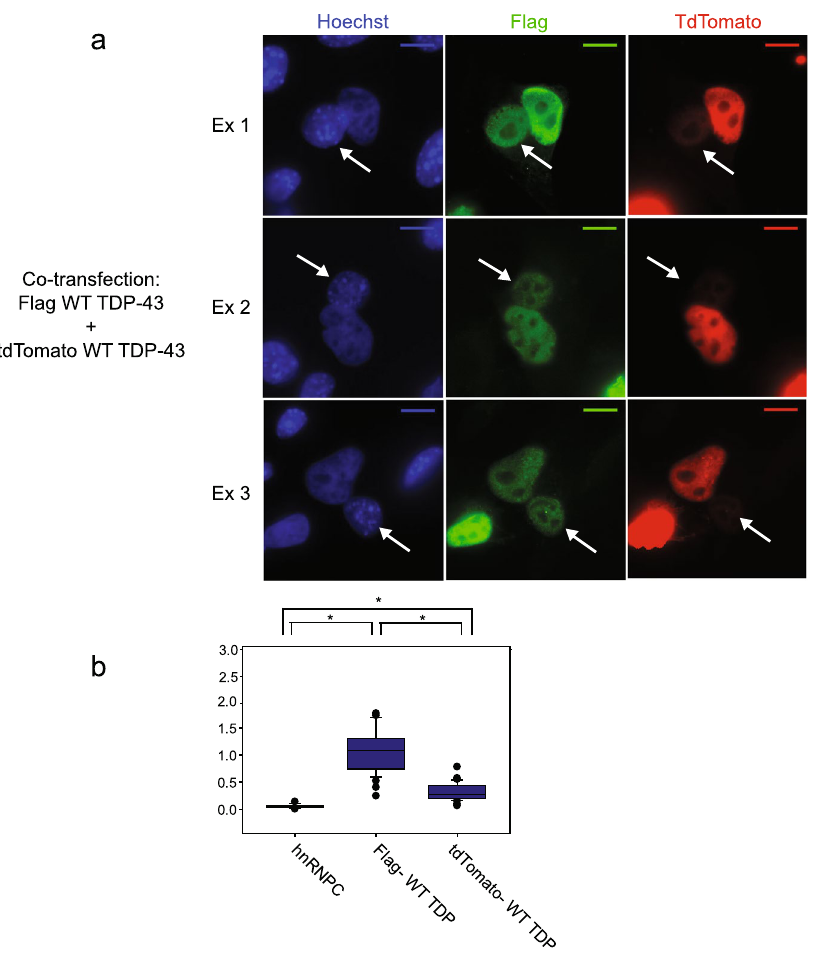
Figure 8. Addition of a bulky tag on TDP-43 disrupts nuclear export. ( a ) Example heterokaryons from a variation of the heterokaryon shuttling assay. HeLa cells were co-transfected with Flag TDP-43 and tdTomato TDP-43 and shuttling assay was performed as in Fig. 3. Heterokaryons were identified by presence of Flag TDP-43 within a recipient nucleus. Flag TDP-43 was visualized via immunofluorescence with Flag antibody, tdTomato TDP-43 was visualized via direct fluorescence. Nuclei were detected using Hoechst stain. Images are representative of 4 independent experiments. Recipient nuclei are indicated by arrow. Scale bar- 10um. ( b ) Quantification of shuttling assay as in 1b. Results are pooled from 4 independent experiments. hnRNPC- 15 heterokaryons counted. Cotransfected with Flag TDP-43 and tdTomato TDP-43–28 heterokaryons counted. * indicates significant difference between groups, p < 0.001. To compare hnRNPC vs Flag TDP-43, and hnRNPC vs tdTomato TDP-43, Mann Whitney rank sum test was used. To compare Flag TDP-43 vs tdTomato TDP-43, Wilcoxon signed rank test was